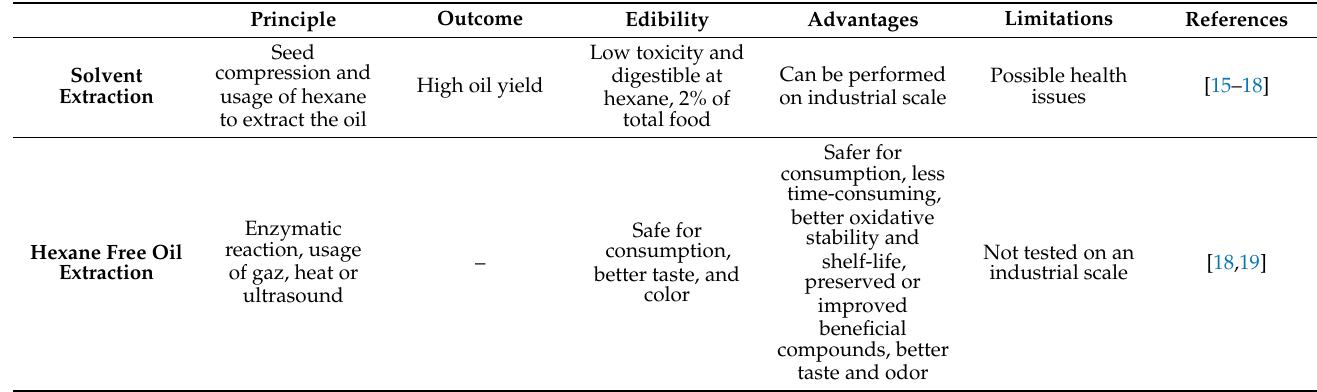
Figure 3. From seeds to processed oil and protein. The chart was built in reference to Unger [15] and the Canola Council of Canada [16]. Each color indicates a different stage of processing: ( 1 ) quality control, ( 2 ) seed pre-treatment, ( 3 ) oil release, ( 4 – 6 ) protein cake processing, ( 7 – 8 ) edible oil refinement, ( 9 ) biodiesel preparation. Table 1. Comparative study of rapeseed oil extraction